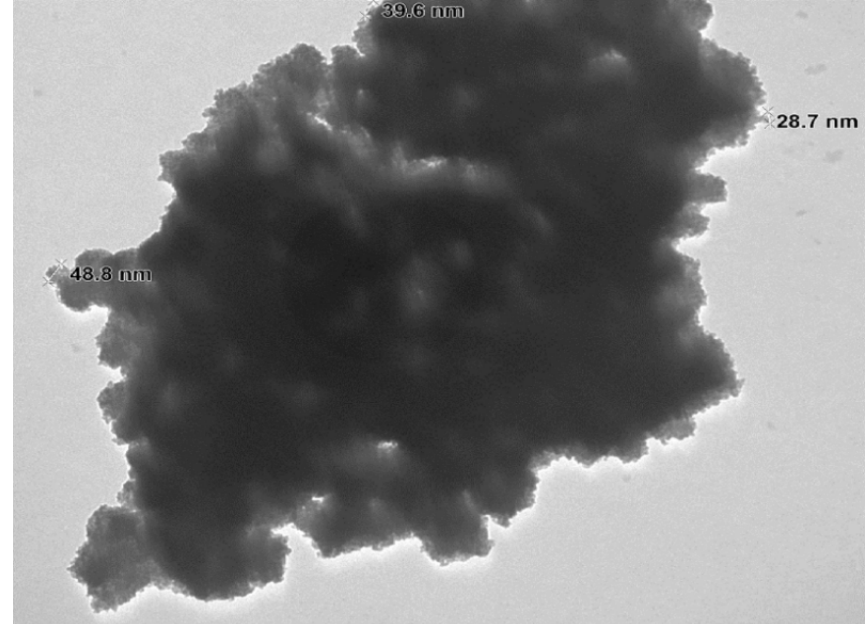
Figure 6. TEM image of zeolite.